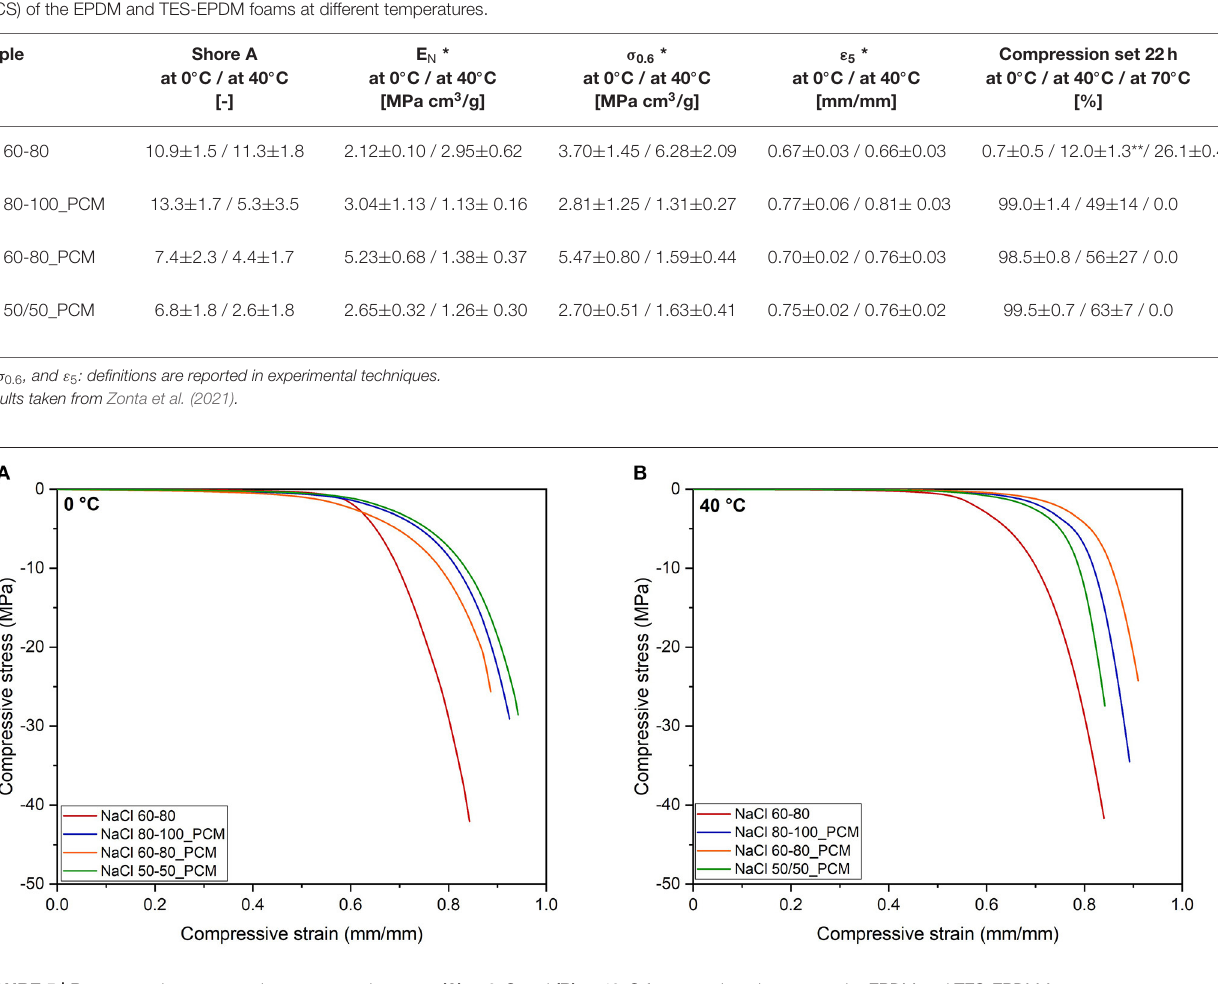
FIGURE 5 | Representative compression stress–strain curves (A) at 0 ◦ C and (B) at 40 ◦ C from quasi-static tests on the EPDM and TES-EPDM